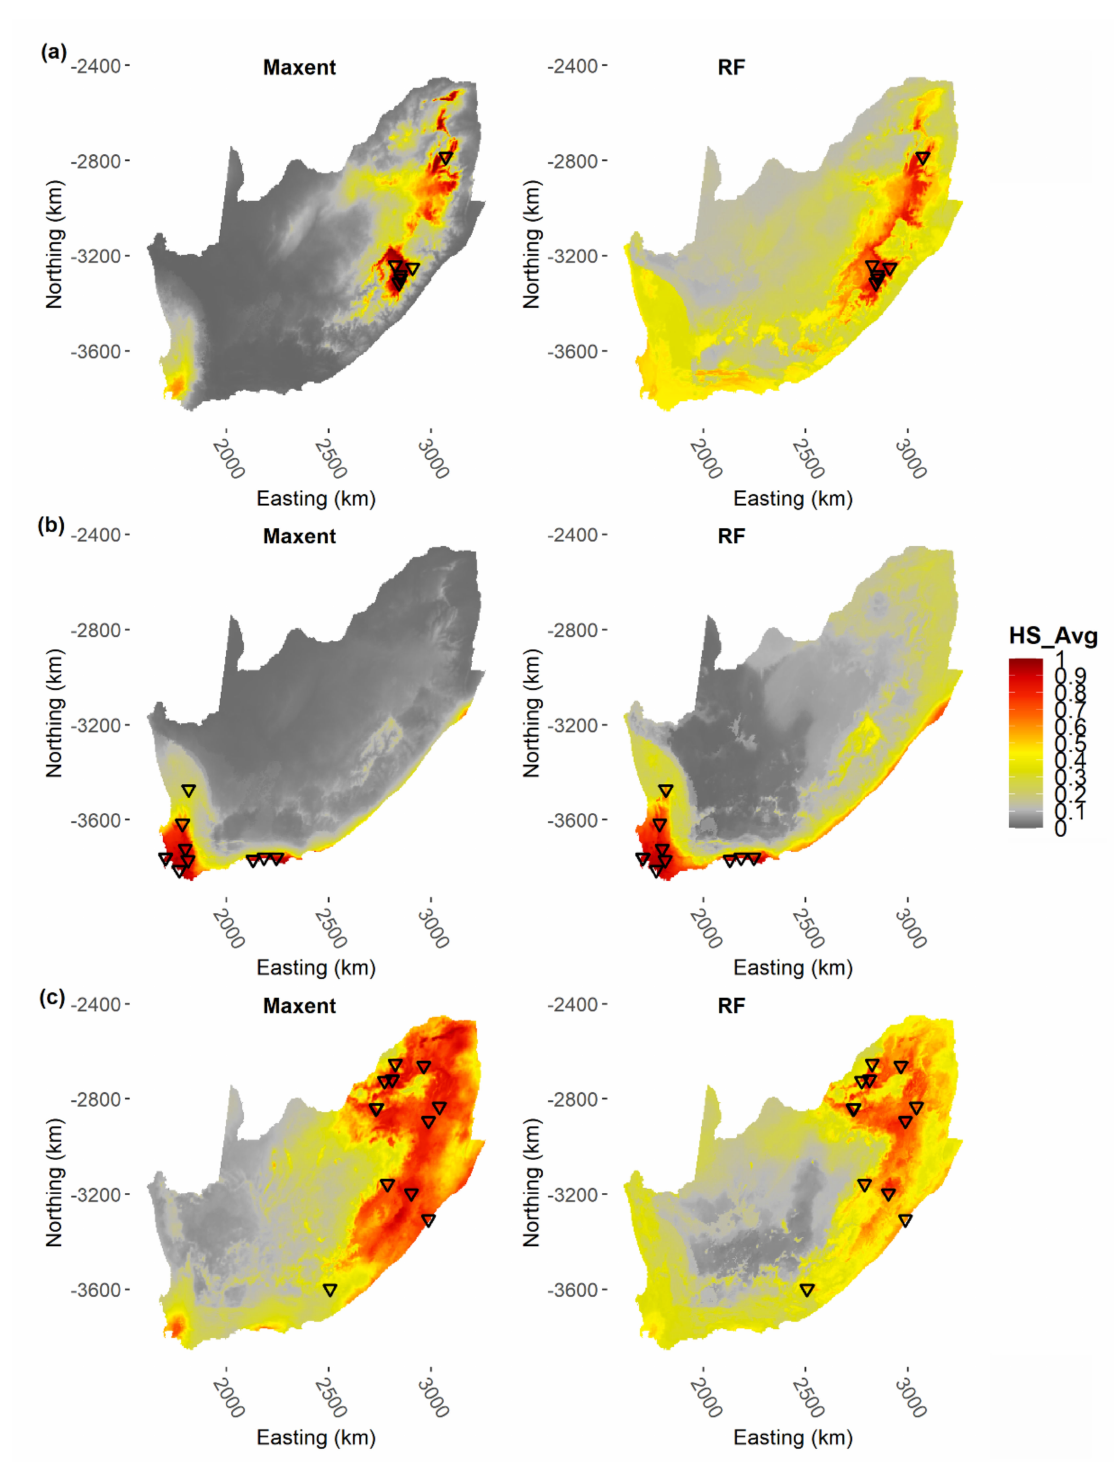
Figure 4. Weighted average predicted habitat suitability (HS_Avg) across the study region resulting from the tuned Maxent and Random Forests (RF) models for: ( a ) Chaetocnema brincki ; ( b ) C. danielssoni ; ( c ) C. gahani . Reversed black-contoured triangles indicate the species’ occurrence